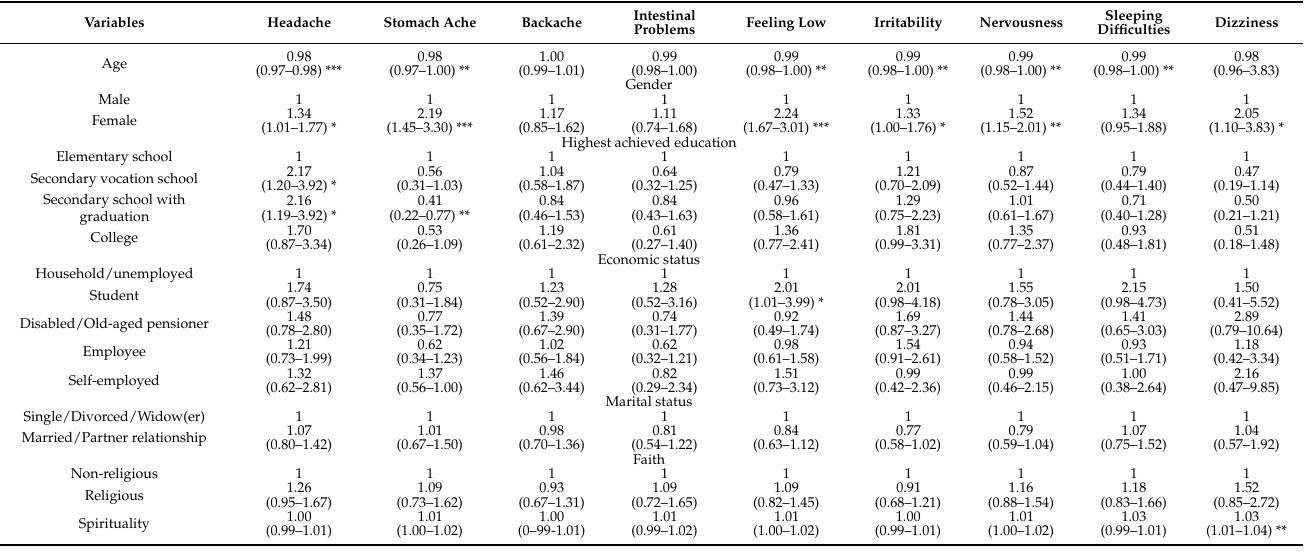
Table 4. Associations of increased frequencies of health complaints with sociodemographic factors adjusted for age, gender and education (OR, 95%